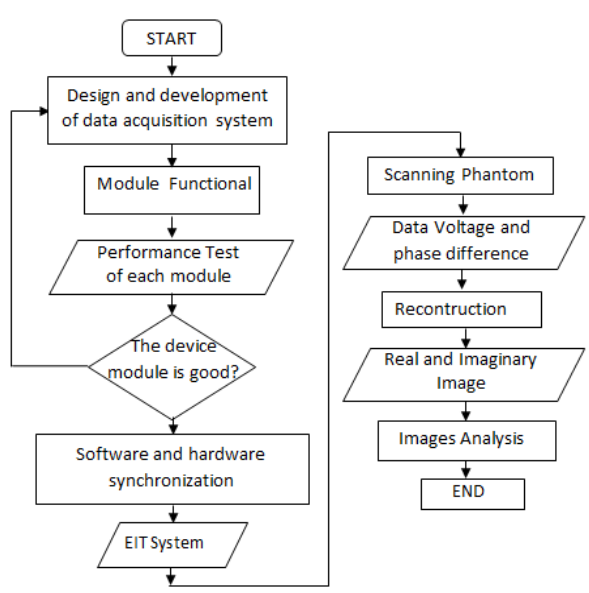
Figure 1. Schematic diagram of the experimental procedure.